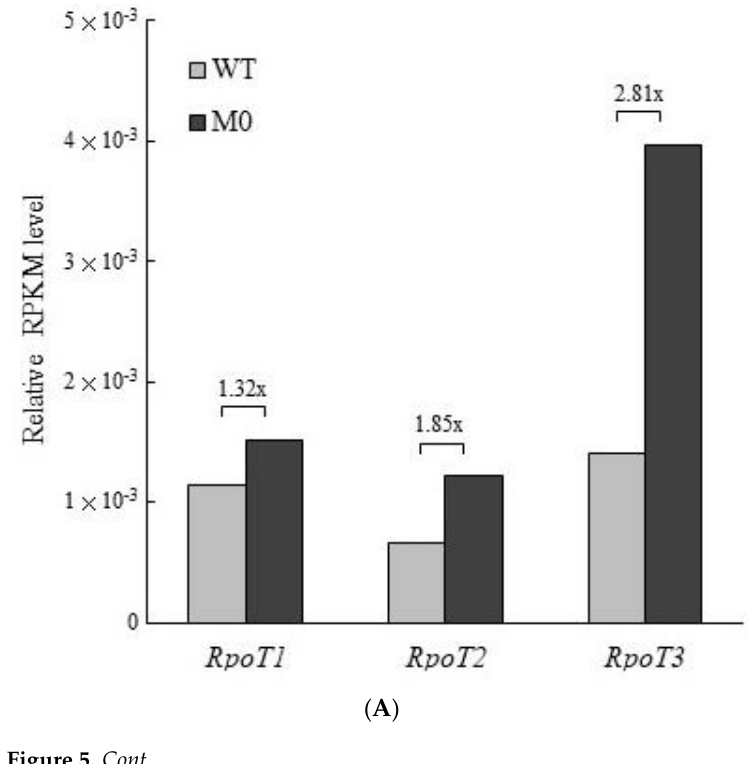
( B ) Figure 5. The relative expression levels of nucleus-encoded RpoT genes between PEP-deficient to- bacco and wild-type plants. ( A ). The relative RPKM analysis was used to measure the relative ex- pression levels of nucleus-encoded RpoT ( RpoT1 , RpoT2 and RpoT3 ) genes by mapping the RNA-Seq reads from the leaf tissues of the PEP-deficient (M0) tobacco and wild-type (WT) plants to the cor- responding templates using the CLC Genomic Workbench 10 with the parameters of L = 0.8 and S = 0.8. The RPKM of nuclear EF-1 α transcripts was used for normalization, set to 1. ( B ). A qRT-PCR assay with the gene-specific primers (Supplementary Table S1) was used to measure the relative levels of RpoT1 , RpoT2 and RpoT3 transcripts between the PEP-deficient (M0) tobacco and wild-type (WT) plants, with nuclear EF-1 α mRNA as a control. The qRT-PCR assay was carried out in tripli- cate. Data are means  SD.